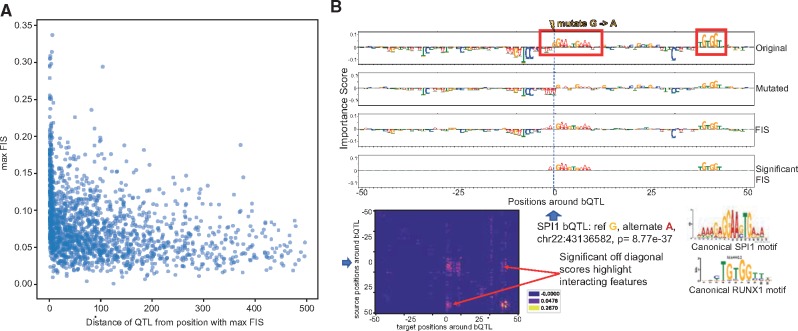
(A) Maximum absolute feature interaction scores (FIS) (y-axis) as a function of distance between SPI1 bQTL and maximally interacting nucleotide within 1 kbp of the bQTL. (B) Example of a SPI1 bQTL showing significant interactions with an overlapping SP1 motif and a proximal RUNX1 motif 40 bp from the bQTL. Row 1 and 2 show the feature importance scores of each nucleotide around the bQTL for the reference and alternate allele respectively. Row 3 in both panels show the feature interaction scores (FIS) indicating the change in importance when the reference allele is mutated to the alternate allele. Row 4 shows only statistically significant interactions. Row 5 shows the deep feature interaction map as a heatmap